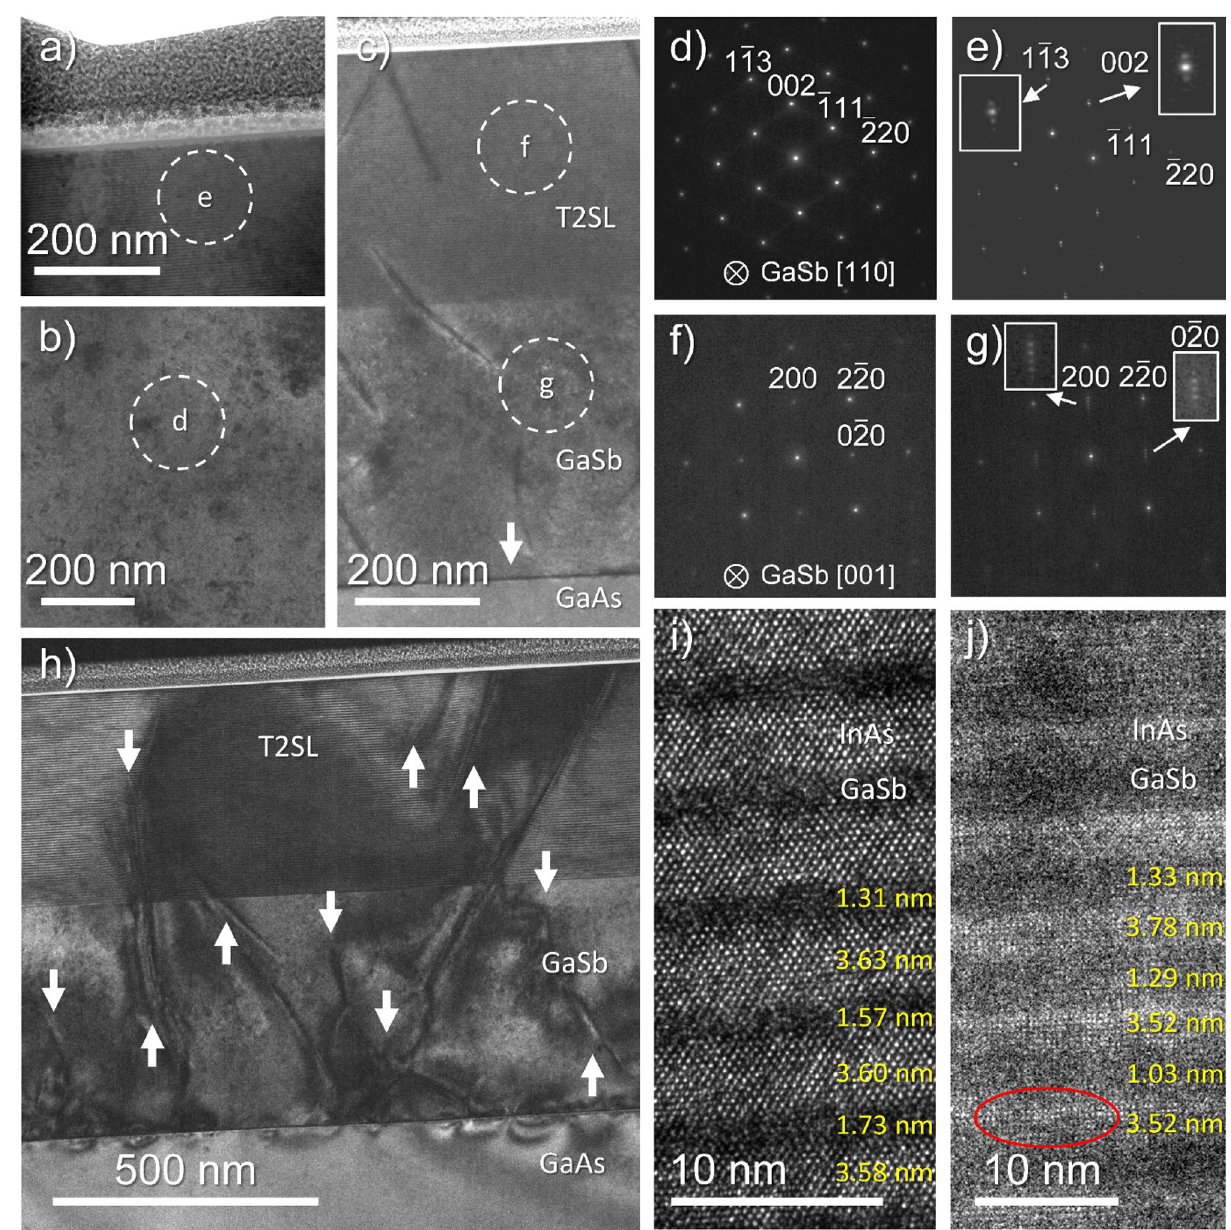
Figure 2. CTEM micrographs from a cross-section of sample A: top layers of the T2SL ( a ) and GaSb substrate ( b ). CTEM image of the whole heterostructure in sample B observed in cross-section ( c ). White circles mark the approximated regions of included SAED patterns ( d )-( g ). 2B-DC-BFTEM micrograph of sample B ( h ) and HRTEM images from the middle T2SL region in samples A ( i ) and B ( j ), including some thickness measurements. In the latter, a red circle is included as a guide to the eye to identify some atomic columns more